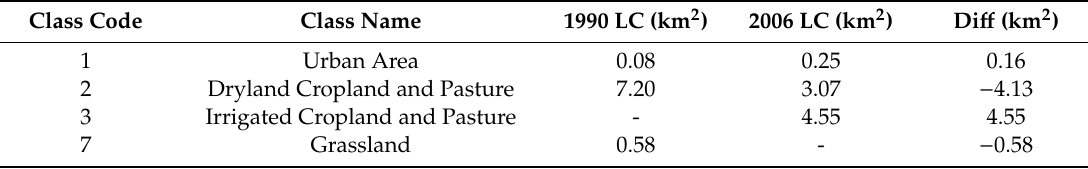
Table 7. LCLU changes between 1990 and 2006 in the fourth selected sub-basin (Sub-Basin 36). Class